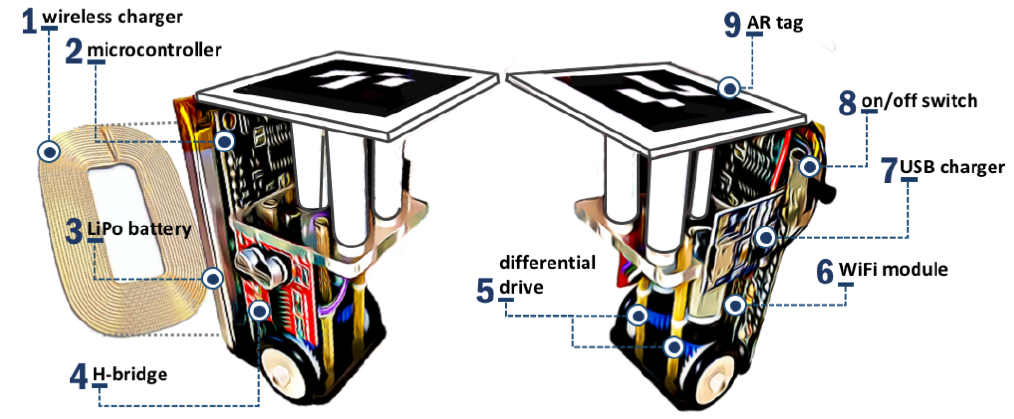
Figure 6. Main components of WsBot.